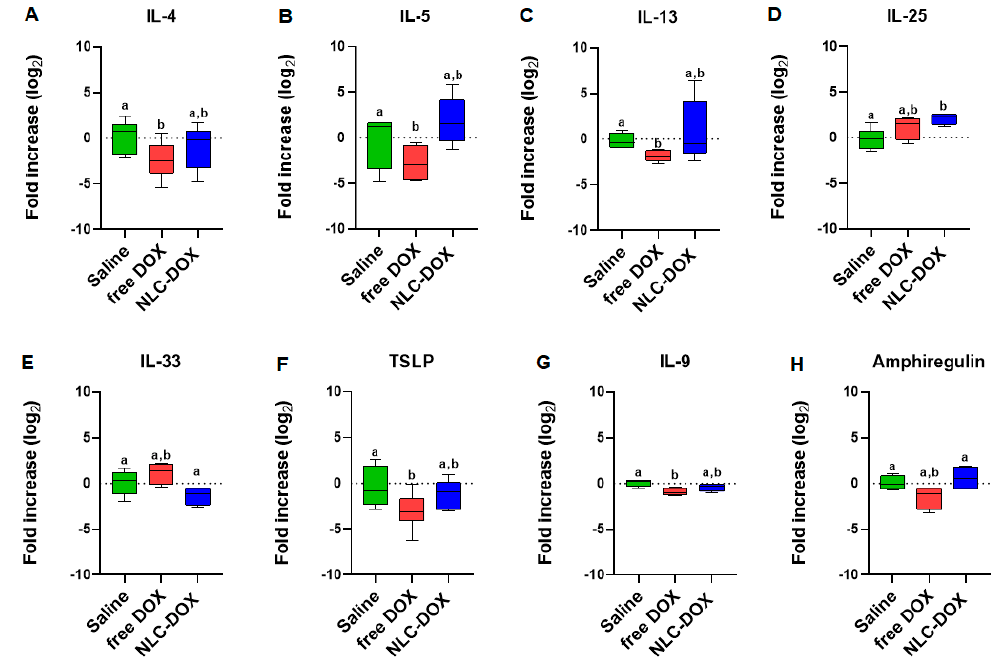
Figure 7. Cytokine expression by real time RT-PCR of ( A ) IL-4, ( B ) IL-5, ( C ) IL-13, ( D ) IL-25, ( E ) IL-33, ( F ) TSLP, ( G ) IL-9 and ( H ) Amphiregulin. Statistical analysis was performed by using the ANOVA test, followed by the Tukey test. Different letters represent p < 0.05. N = 15 animals per group. Data are a pool from 3 experiments performed. Abbreviations: DOX, doxorubicin; NLC, nanostructured lipid